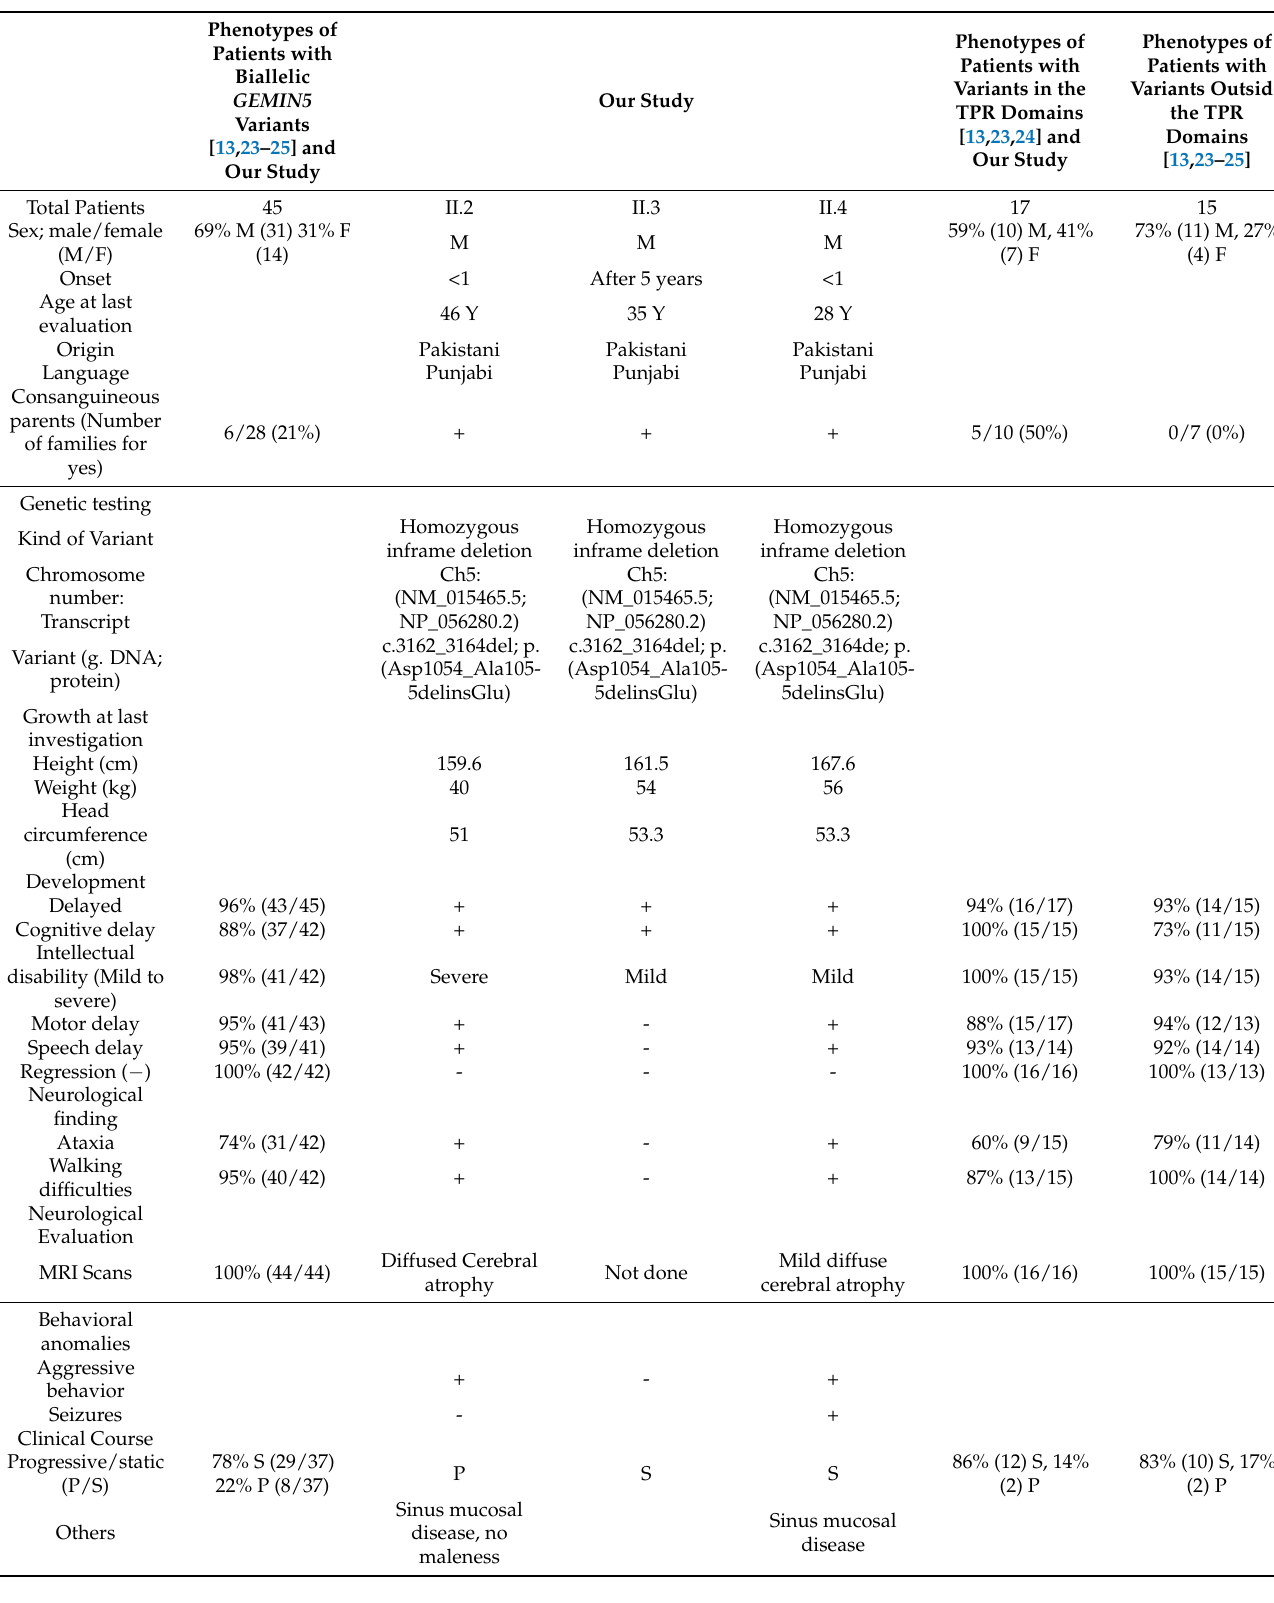
Table 1. Clinical features of patients with biallelic GEMIN5